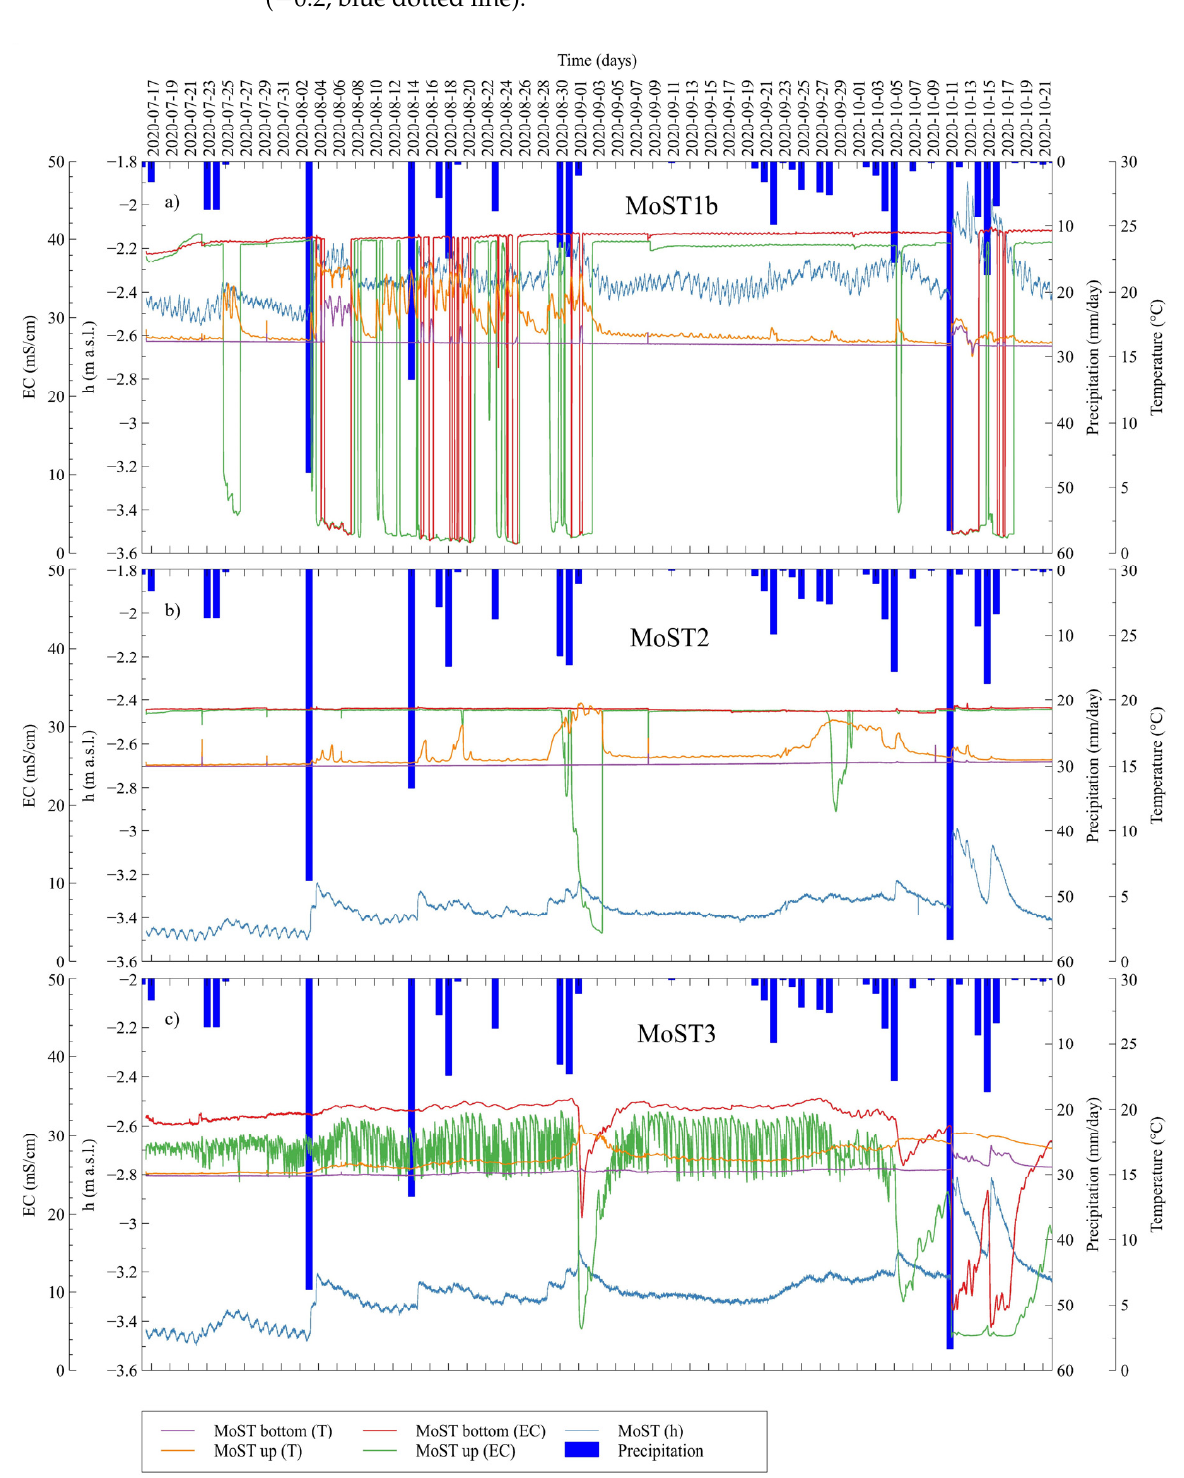
Figure 9. Groundwater dynamics of the unconfined aquifer in the period July 16th–October 22nd. EC and T detected at the top and the bottom of the aquifer: ( a ) piezometer MoST1b at − 3.94 and − 6.48 m a.s.l.; ( b ) piezometer MoST2 at − 4.11; and − 7.83 m a.s.l.; and ( c ) piezometer MoST3 at − 4.03 and − 10.52 m